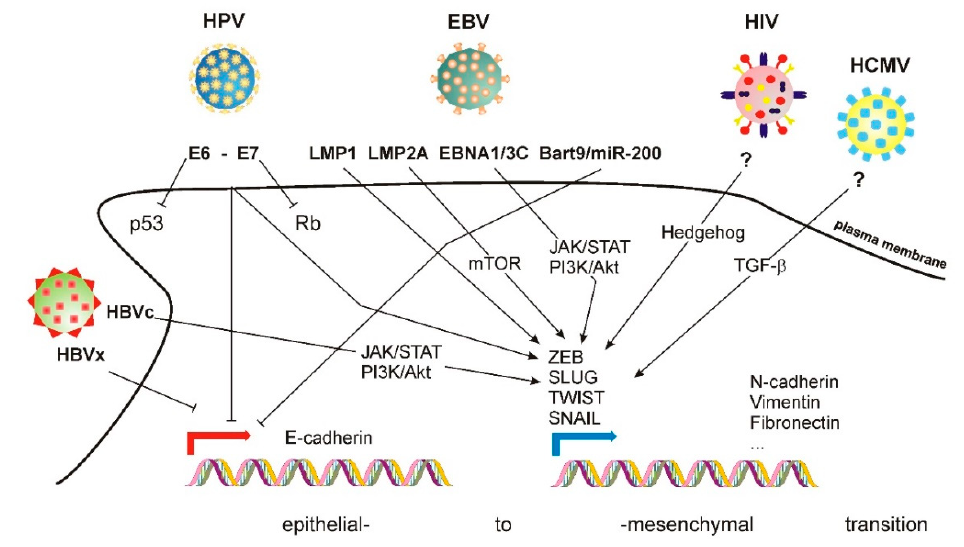
Figure 1. Mechanisms of EMT induced by several families of viruses. See accompanying text for details.